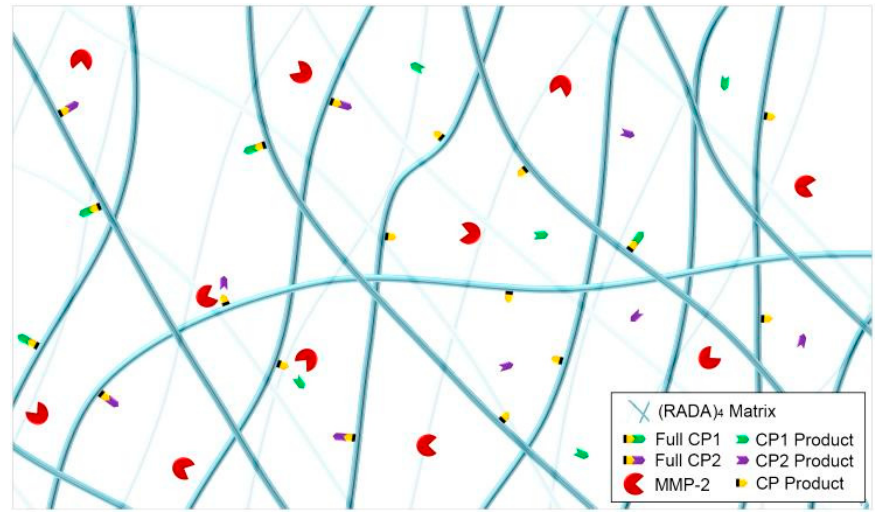
Figure 1. Schematic of nanofiber formation and MMP ‐ 2 cleavage of (RADA) 4 , (RADA) 4 ‐ GG ‐ GPQG+IASQ (CP1), and (RADA) 4 ‐ GG ‐ GPQG+PAGQ (CP2). “+” Denotes cleavage site and CP1, CP2, and CP products are IASQ, PAGQ, and (RADA) 4 ‐ GG ‐ GPQG, respectively.